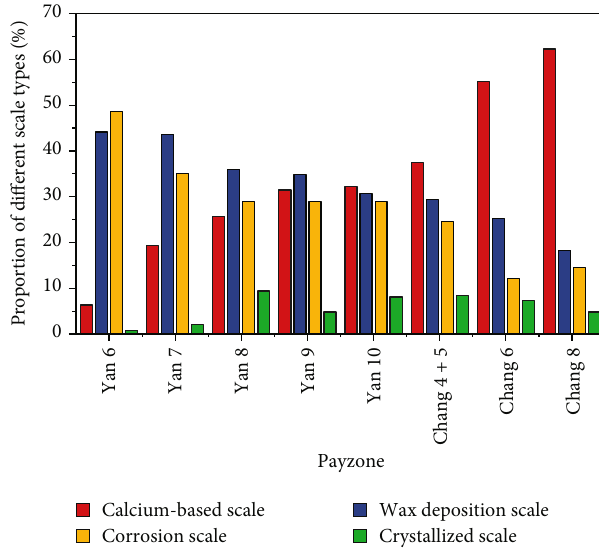
Figure 7: Scale type distribution by